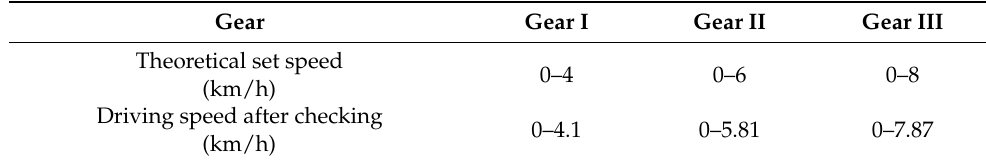
Table 7. Tractor speed in each